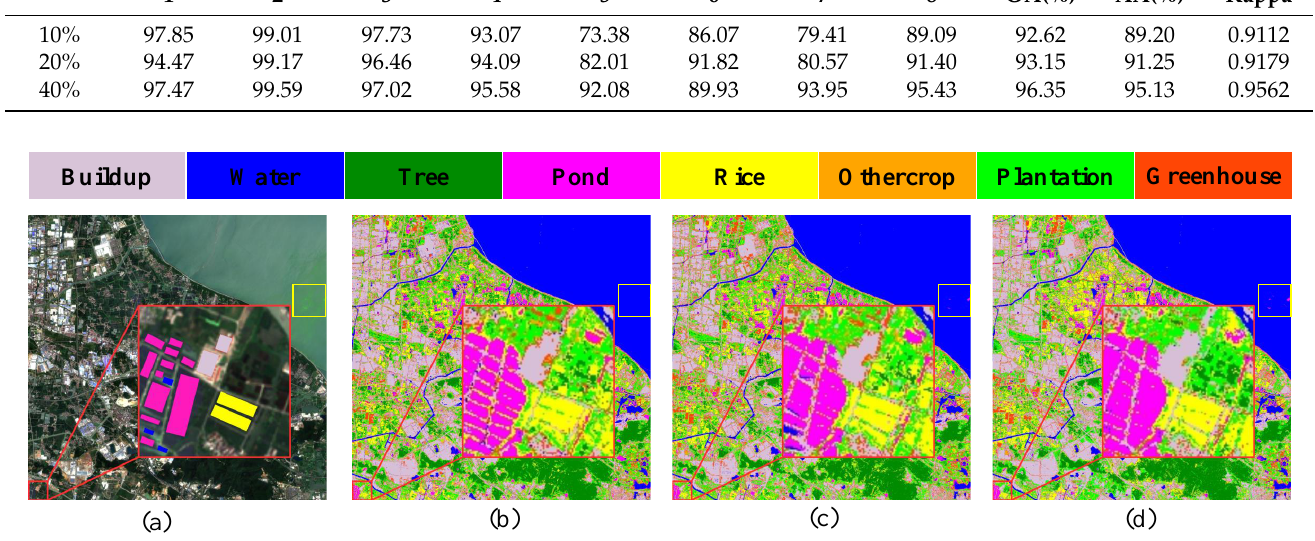
Figure 8. Plots of training sample results with different ratios: ( a ) Original image; ( b ) 10%; ( c ) 20%; and ( d )